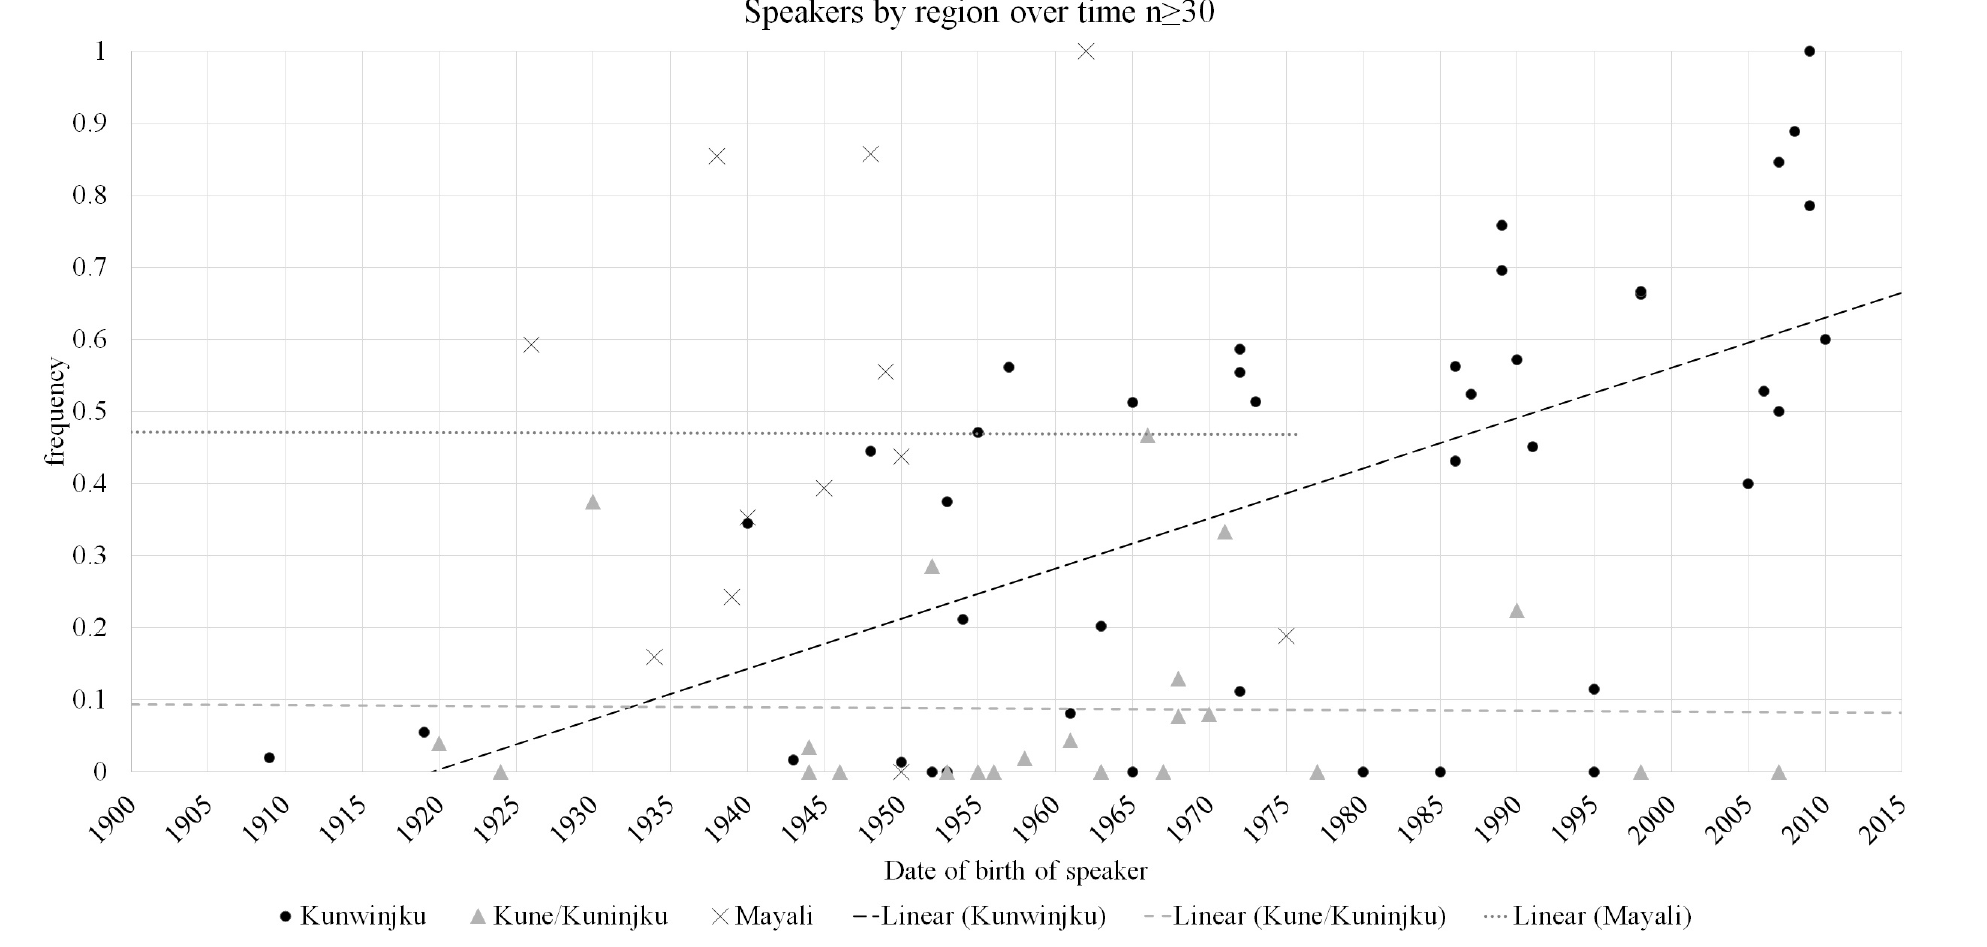
Figure 2. Word-initial engma deletion over time. For a longer discussion and deeper analysis of this phenomenon, see Marley (2020, chap. 3), forthcoming. Reprinted with permission from Marley